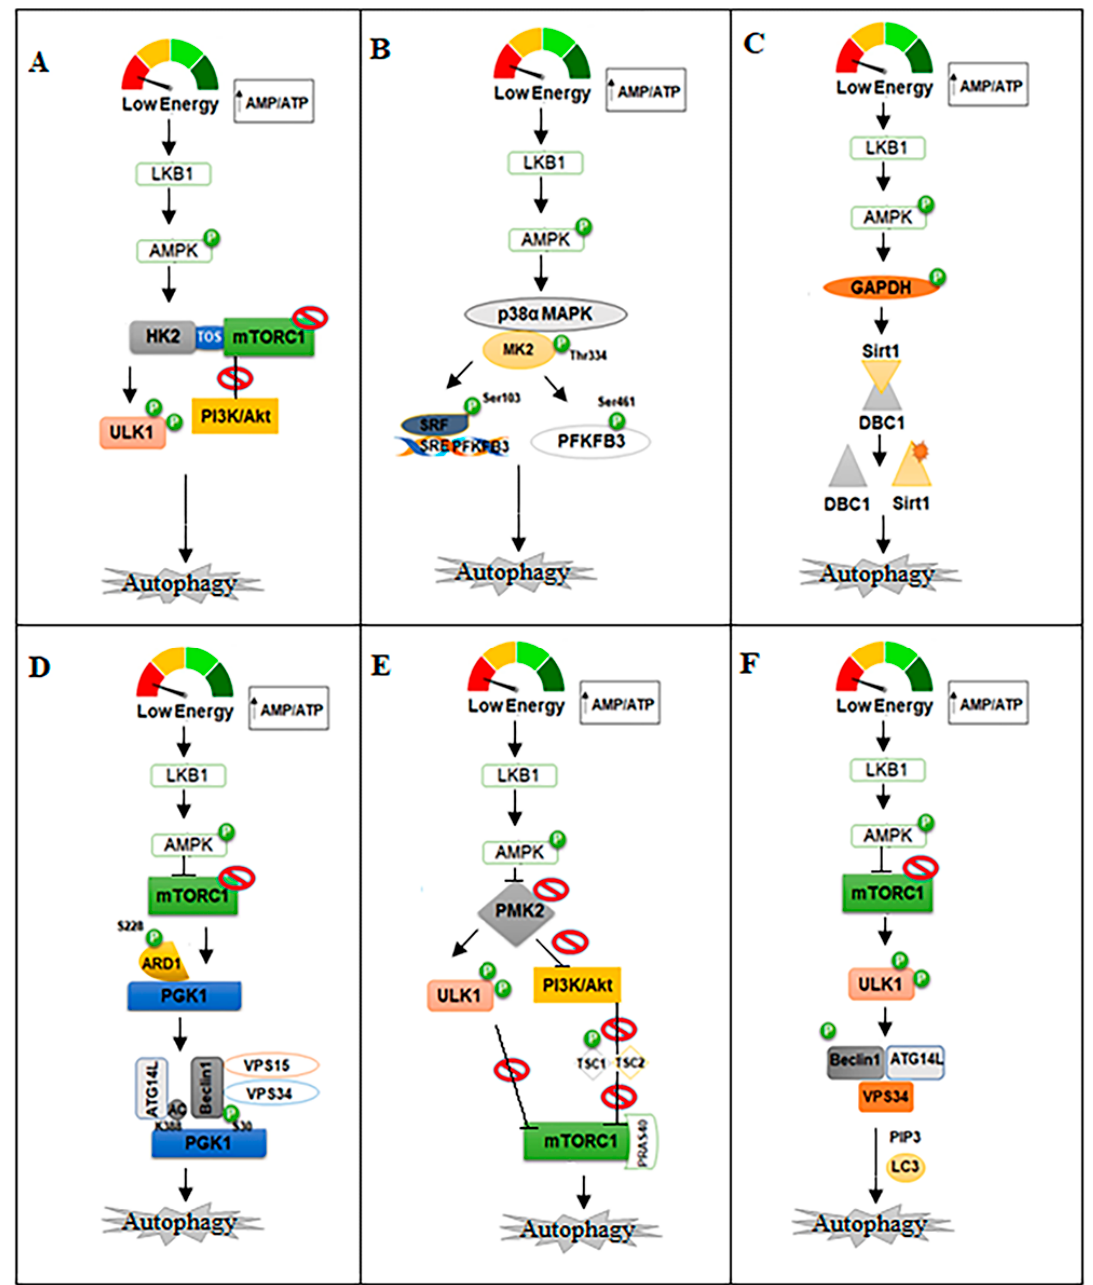
Figure 3. Autophagy is regulated by multiple signaling pathways, which creates a complex interaction system. The glycolysis-related enzymes and glycolysis metabolic intermediates ( A – F ) are involved in the regulation of autophagy, acting as a double-edged sword to sustain cancer cell survival under conditions of energy shortage.